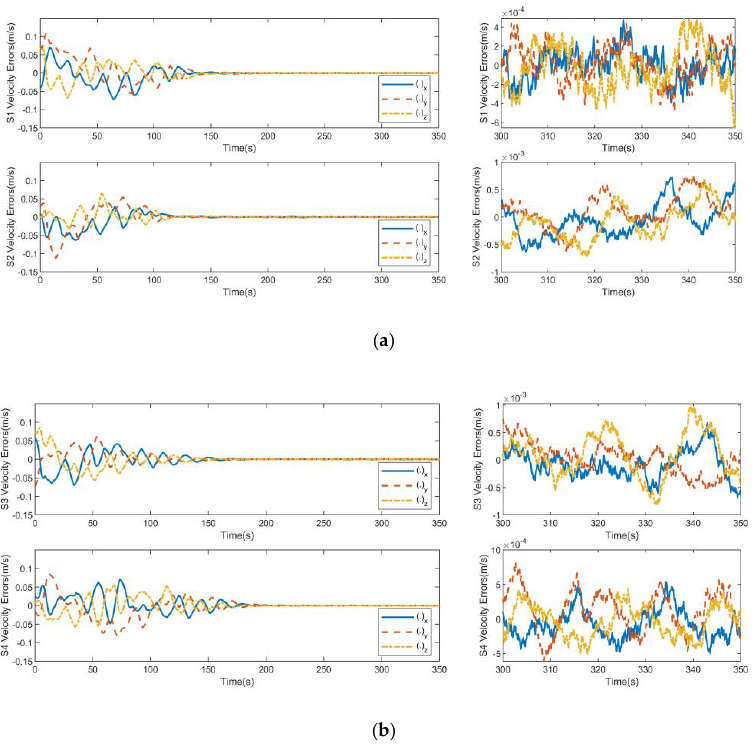
Figure 10. Velocity errors for consistent collaborative control. ( a ) S1 velocity errors and S2 velocity errors; ( b ) S3 velocity errors and S4 velocity errors. As shown in Figures 11 and 12, the attitude angle error and attitude angular velocity error can reach the steady state within 23 s under the action of attitude controllers. Due to the presence of spatial uncertainty and continuous interference torque, the attitude angle control accuracy of the controller of the cooperative item is 0.002°, and the attitude angular velocity control accuracy of the controller of the cooperative item is 0.001°/s.